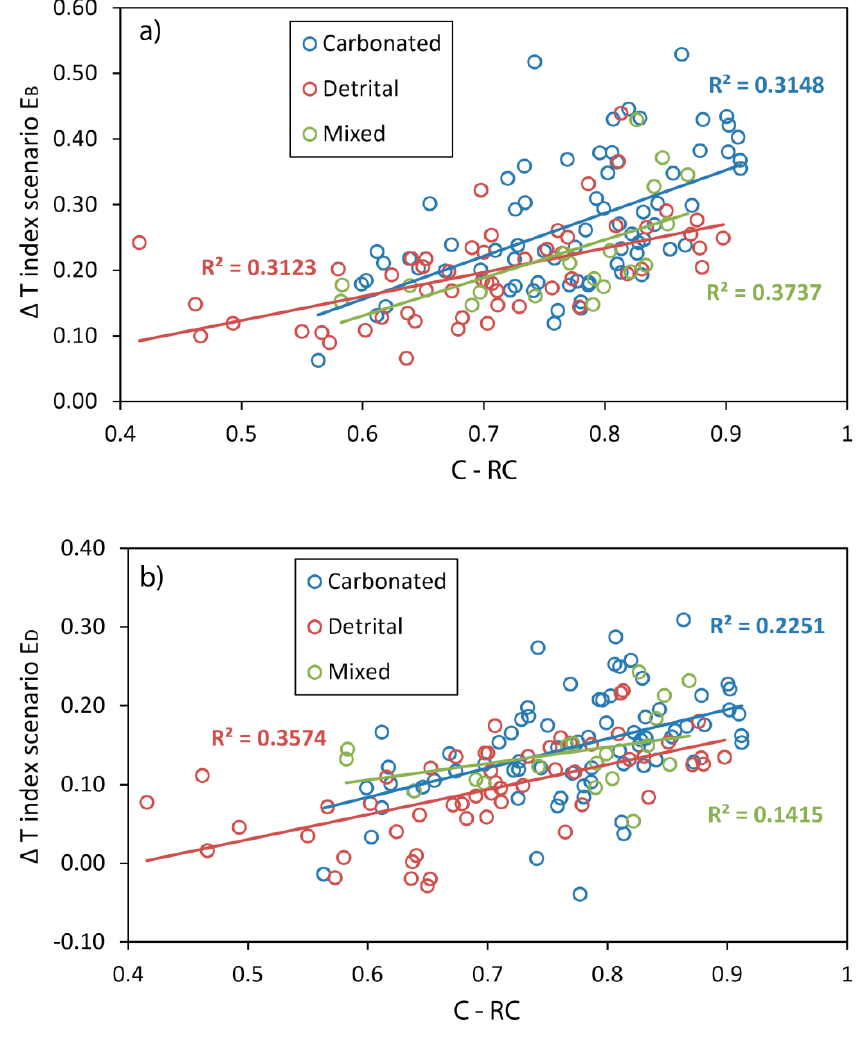
Figure 11. Absolute distance (years) of future T values ( a ) EB scenario and ( b ) ED scenario, with respect to the historical T vs. difference between effective recharge coefficients and recharge coefficients.